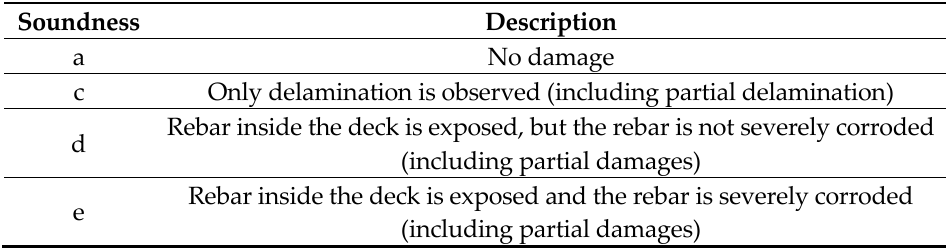
Table 1. The criteria of judging soundness of delamination (defined in the inspection code of Niigata Prefecture (Niigata Prefecture,